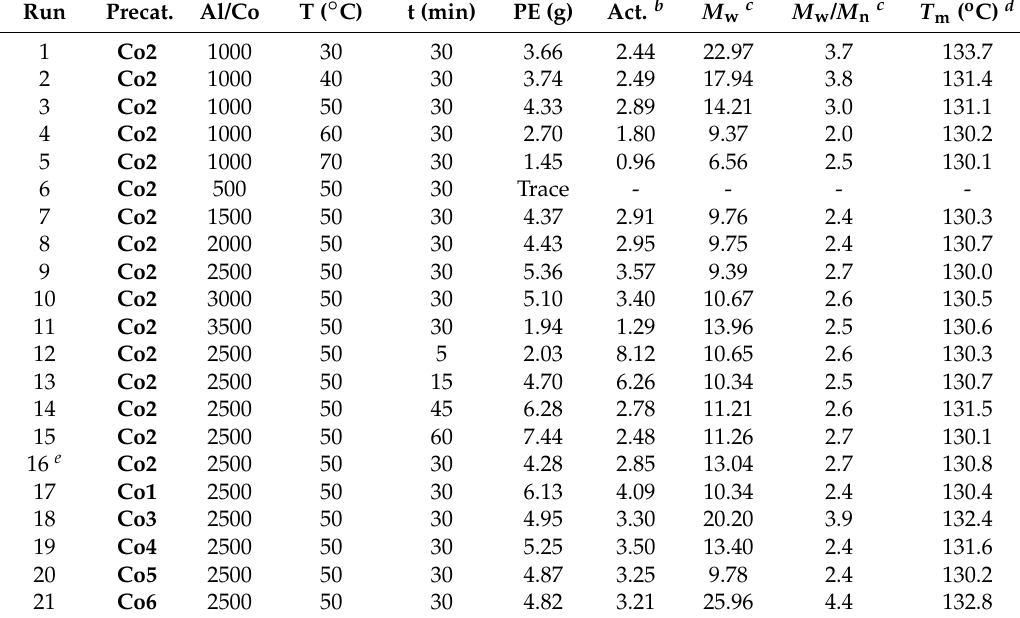
Table 2. Ethylene polymerization results using Co2 / MAO a .